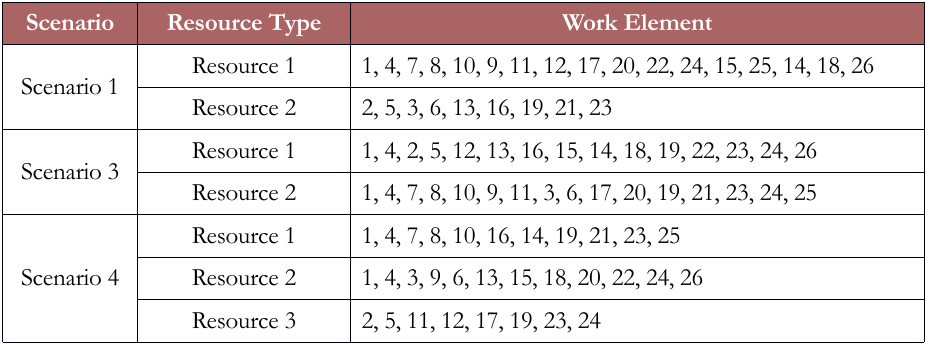
Table 20. Work Element Assignment for Scenario 1,3, and 4